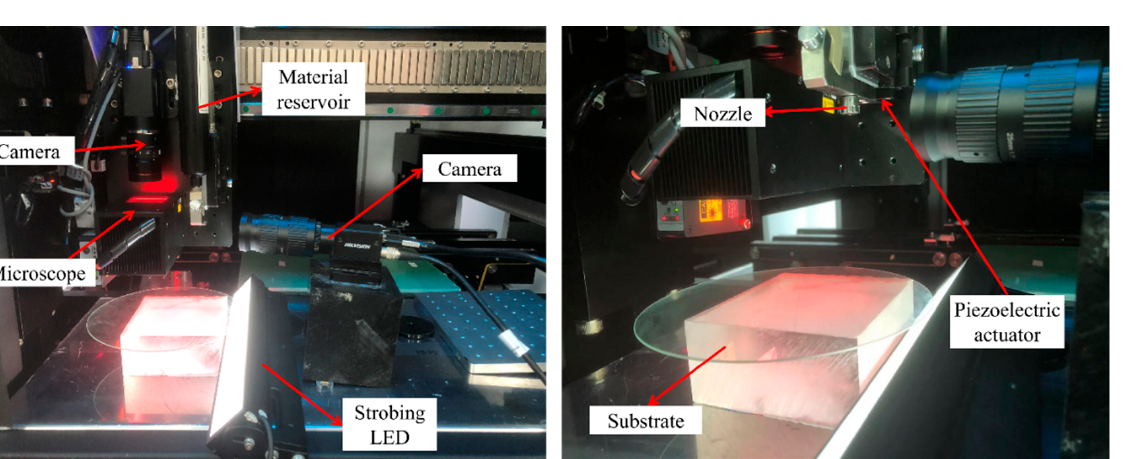
Figure 7. Variation in droplet diameter with time, for different cases. ( a ) variation of droplet diameter with time for different cases, ( b ) case.1, ( c ) case.7, ( d ) case.13, ( e ) case.19, ( f ) case.25, ( g ) case.30.